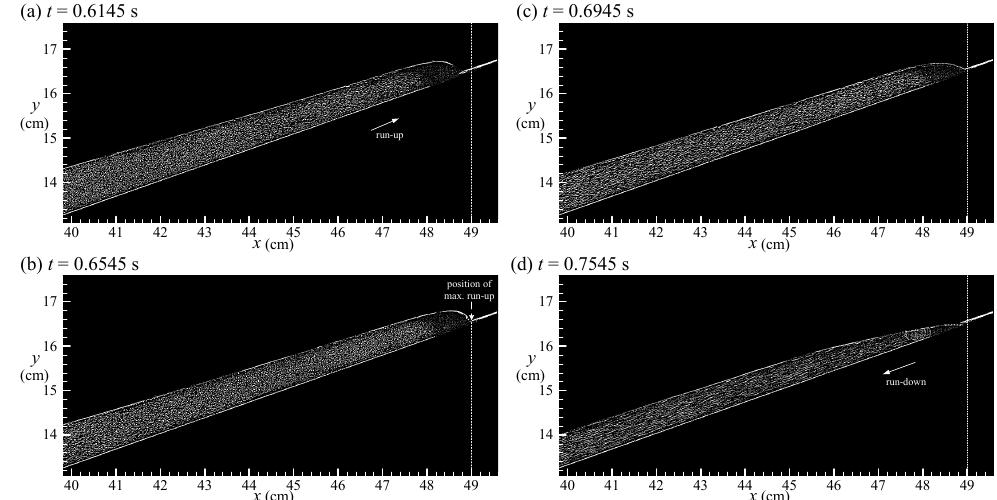
Figure 7. Four visualized images showing the propagation of solitary wave over the sloping beach at t = ( a ) 0.6145 s with run-up motion heading to the maximum run-up height; ( b ) 0.6545 s with the tip of swash front exactly reaching the maximum run-up height; ( c ) 0.6945 s with the tip of swash front staying at a nearly identical position as that at t = 0.6545 s, however, the water particles transporting offshore; and ( d ) 0.7545 s with the tip of free surface and water particles all moving offshore. Following the approach adopted by Chow [25], Subramanya [26] and Henderson [36], the